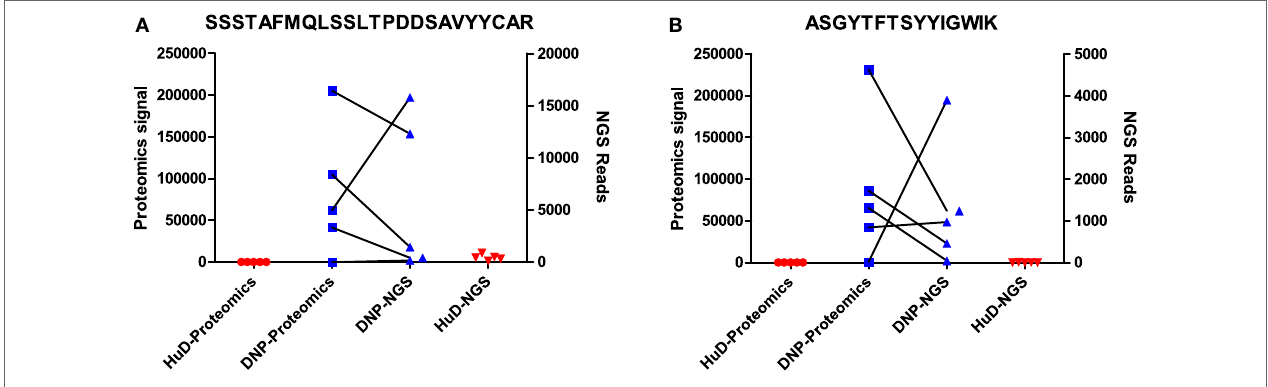
FigUre 3 | Data for two peptides [SSSTAFMQLSSLTPDDSAVYYCAR (a) ; ASGYTFTSYYIGWIK (B) ] that were found to be associated with DNP immune sera in proteomics data. Shown are signal intensities in proteomics, and the number of reads in NGS data containing the same peptide. Matching DNP samples have been plotted with a connecting